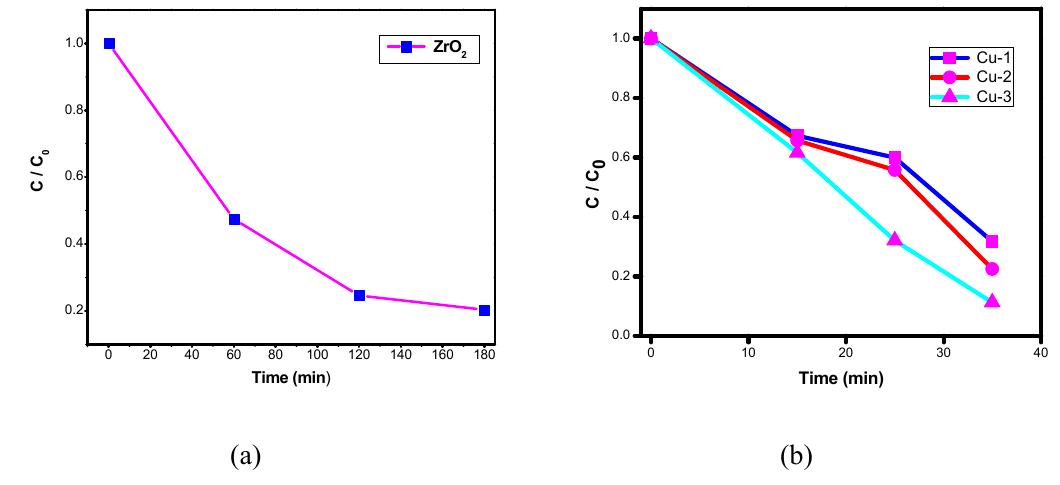
Fig. 9. MB degradation efficiency of (a) pure and (b) Cu doped ZrO